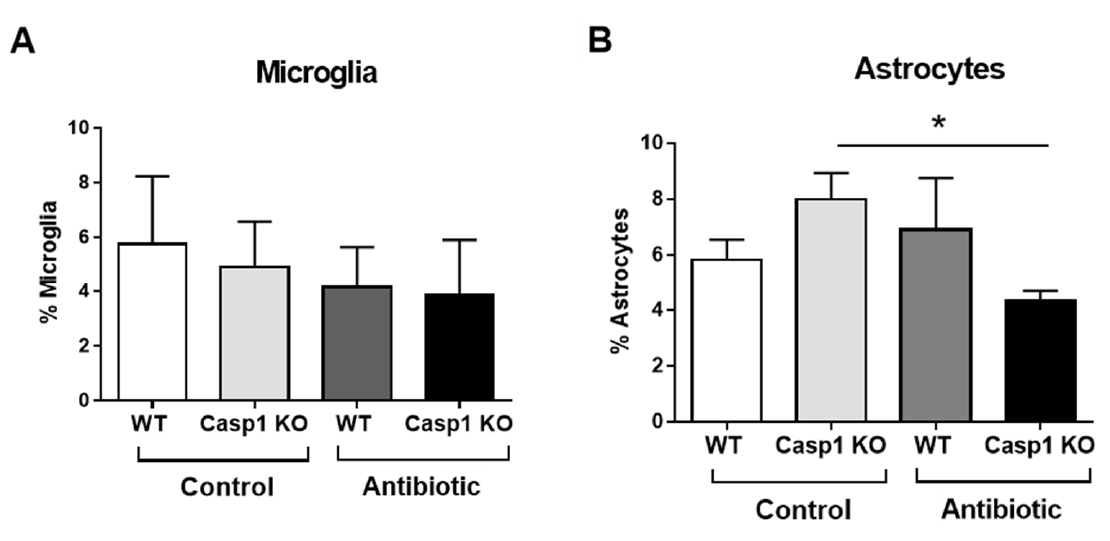
Figure 5. Representative percentage (%) of ( A ) microglia and ( B ) astrocytes cell average in the anterior cingulate cortex (ACC) of WT and Casp1 KO control and antibiotic-treated groups. Data are mean (SD). n = 3/group. *: p < 0.05.